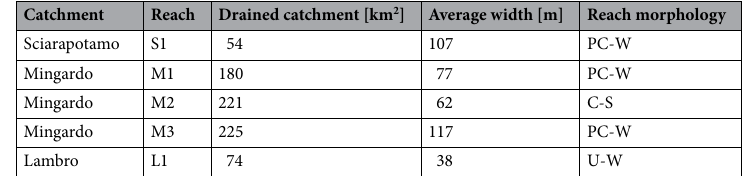
Table 1. Characteristics of the studied reaches. Reach morphology codes: C = confined; PC = partially confined; U = unconfined; W = wandering; S =